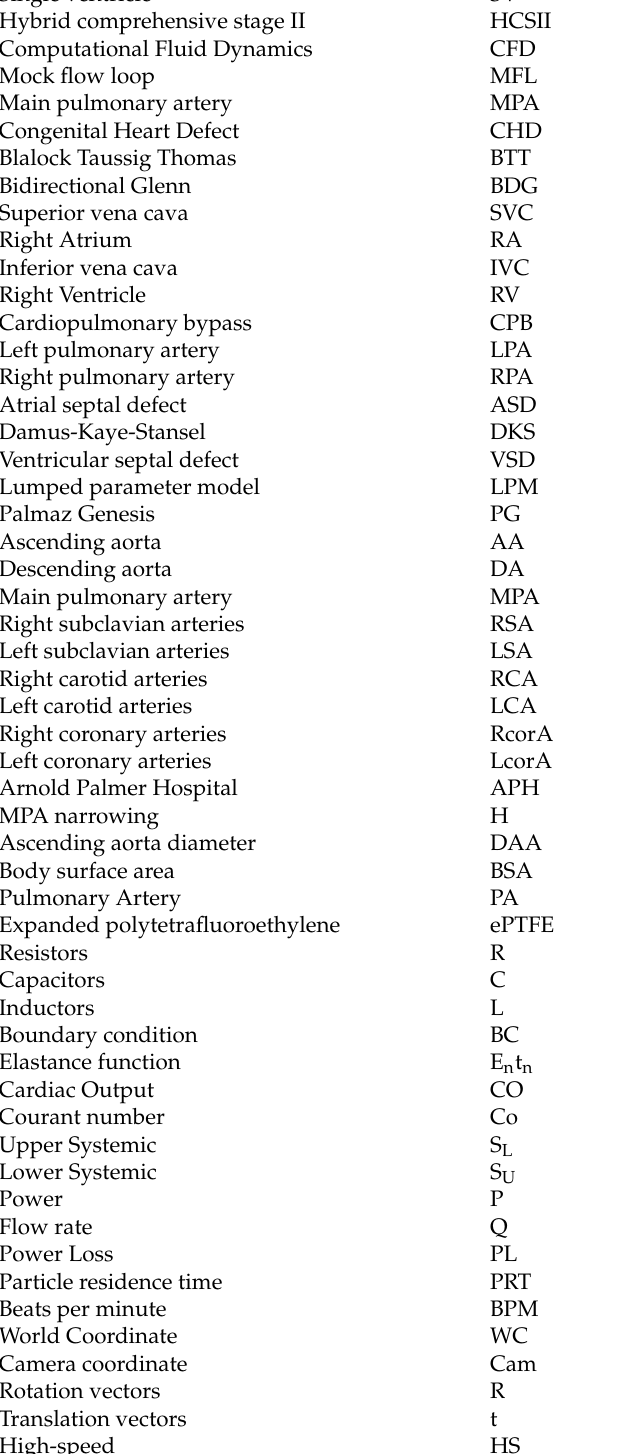
Table A1. This table contains the list of